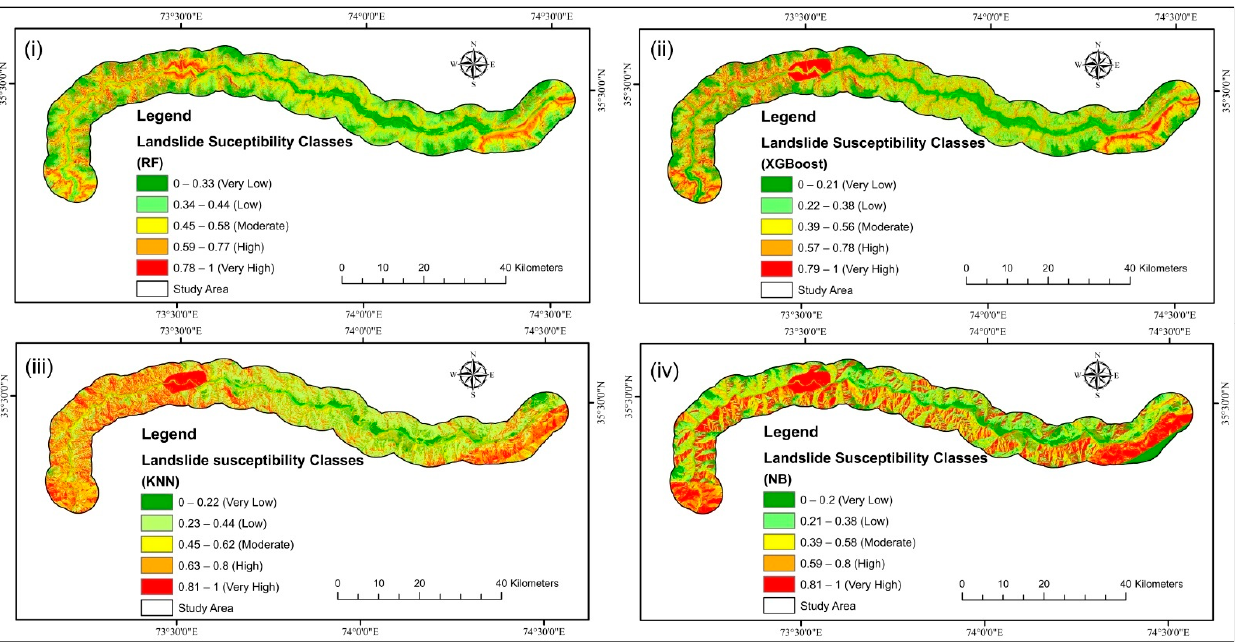
Figure 10. LSM using ( i ) RF, ( ii ) XGBoost, ( iii ) KNN, and ( iv ) NB models.